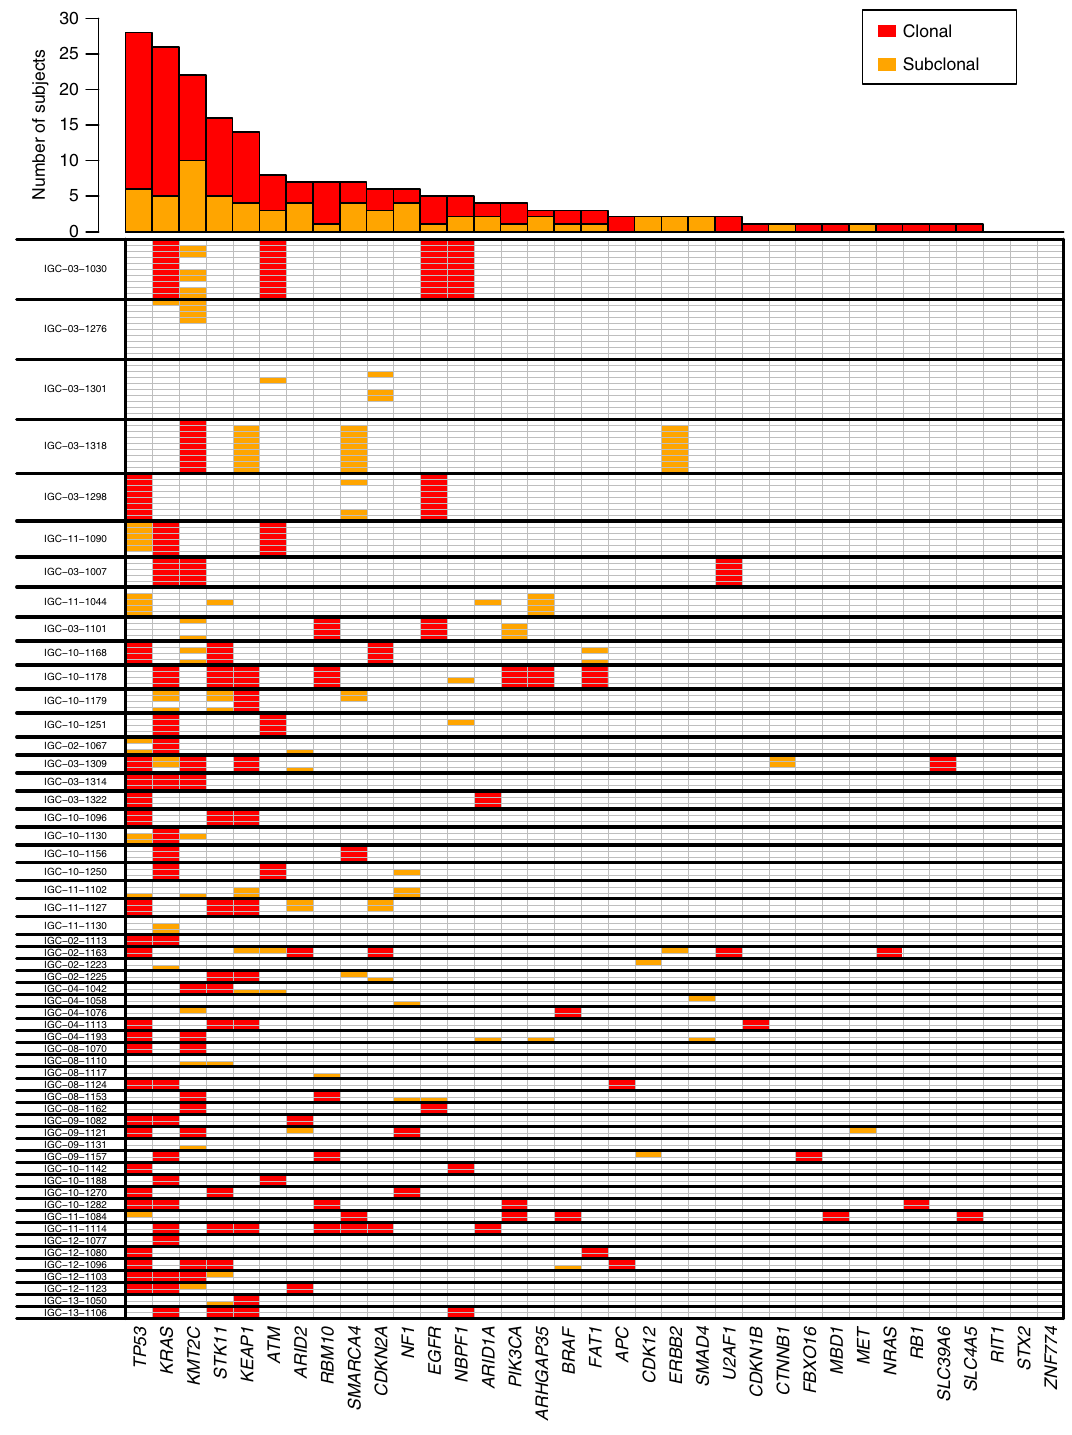
Fig. 2 Intratumor heterogeneity of single nucleotide variants for 35 lung driver genes. Only nonsynonymous mutations are included for analysis. Top panel: the number of public (shared by all tumor samples in a patient) and private (not shared by all tumor samples in a patient) mutations for each driver gene. Bottom panel: summary of intratumor heterogeneity for each gene in each tumor. Thick lines separate the different tumors. Multiple lanes within thick lines indicate multiple samples from the same tumor. Red and orange indicate public and private mutations, evolutionary trees inferred from SCNAs and DNA methylation showed consistent results and supported the congruence between and observed high similarity (Fig. 6b for six tumors with at least SCNAs and methylation (Supplementary Fig. 5, panels A – D for fi ve samples each; Supplementary Fig. 5E for the same analysis 14 tumors with at least four samples each assayed for methyla- based on CpG probes across the whole genome, CpG probes tion, Spearman ’ s correlation coef fi cient ’ s = 0.638 and 0.573 for mapping to SCNA homogenous regions, and CpG probes map- SCNA homogenous and copy-number neutral regions, respec- ping to copy number neutral regions; and Supplementary Fig. 6 tively, p < 1 × 10 − 16 ). We then examined the topology of